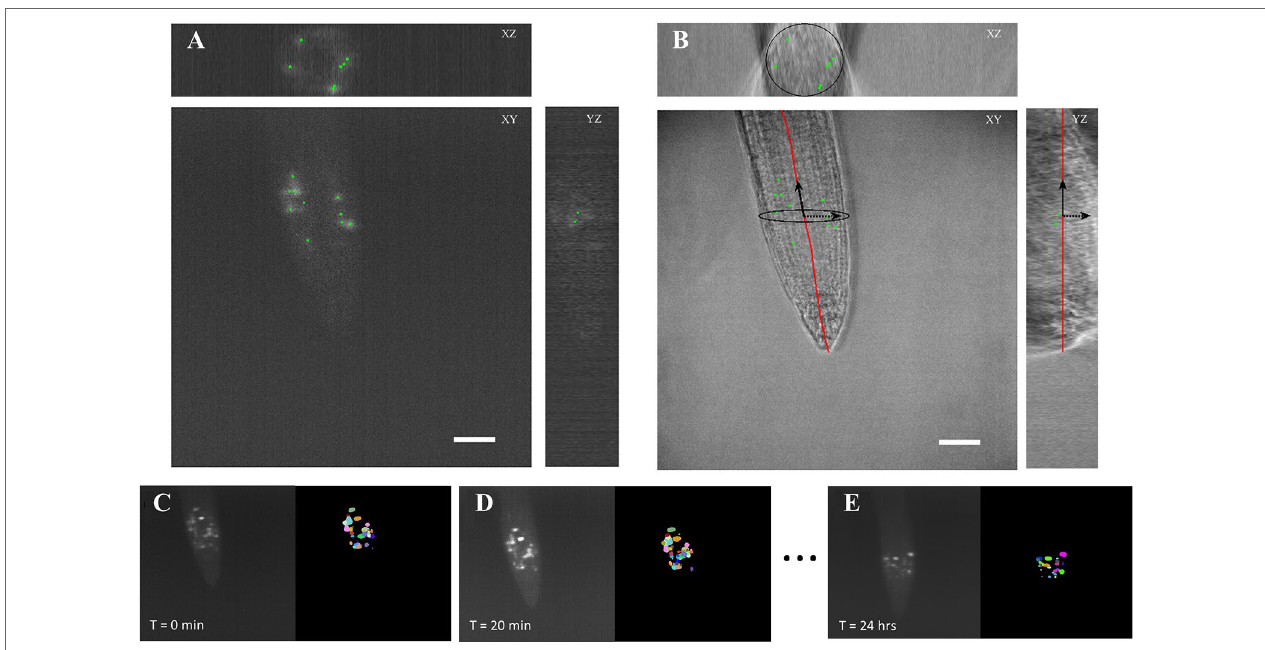
FIgURE 3 | Automated image analysis on 3D light sheet microscopy images. (A) A 3D fluorescent image was taken every 20 min capturing ROIs of the CYCB1;1:GFP signal. The image analysis software distinguished the different ROIs as individual instances. (B) A corresponding 3D brightfield image was taken every 20 min in the light sheet growth chamber to capture the overall structure of the A. thaliana root. The ROI locations were on to the processed coordinate system of the root. Scale bars = 50 μ m. (C – E) Segmentation and tracking of the 3D images max projected onto 2D images. Segmented ROIs of the same color indicates the same region in different time